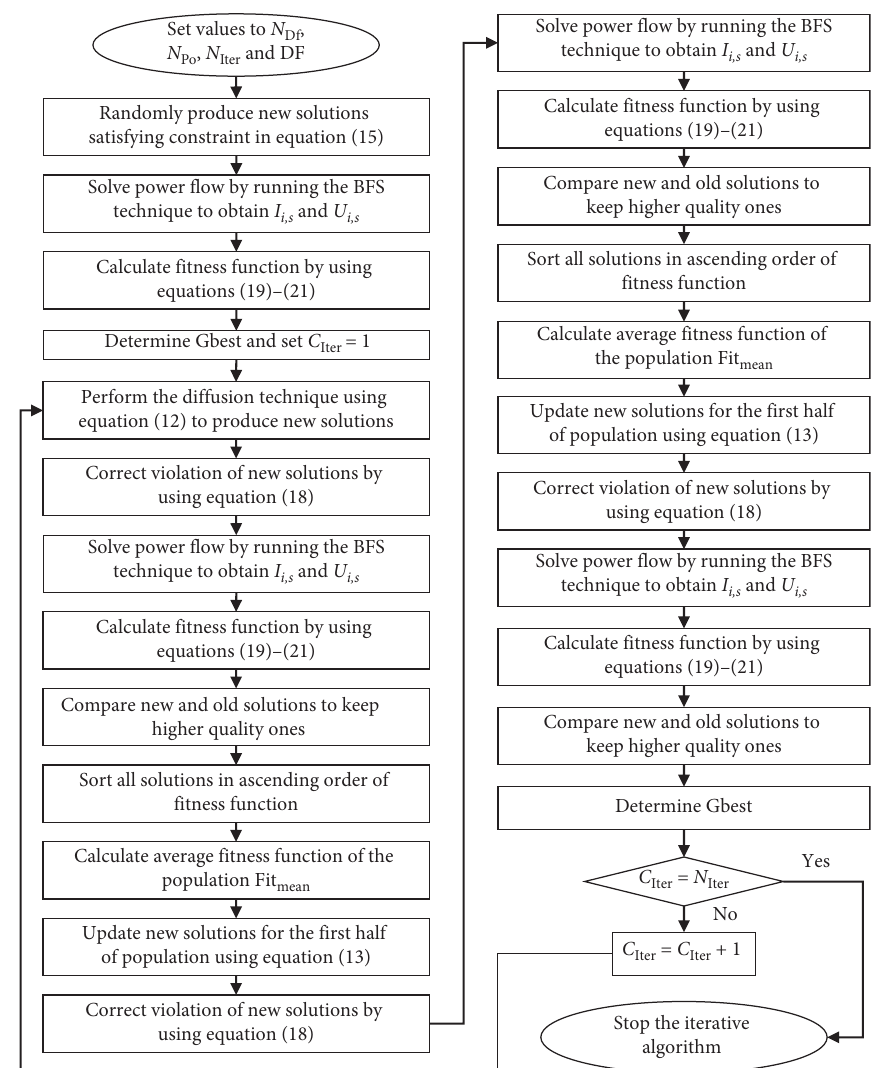
Figure 1: The MFS method implementation procedure for capacitor placement in distribution